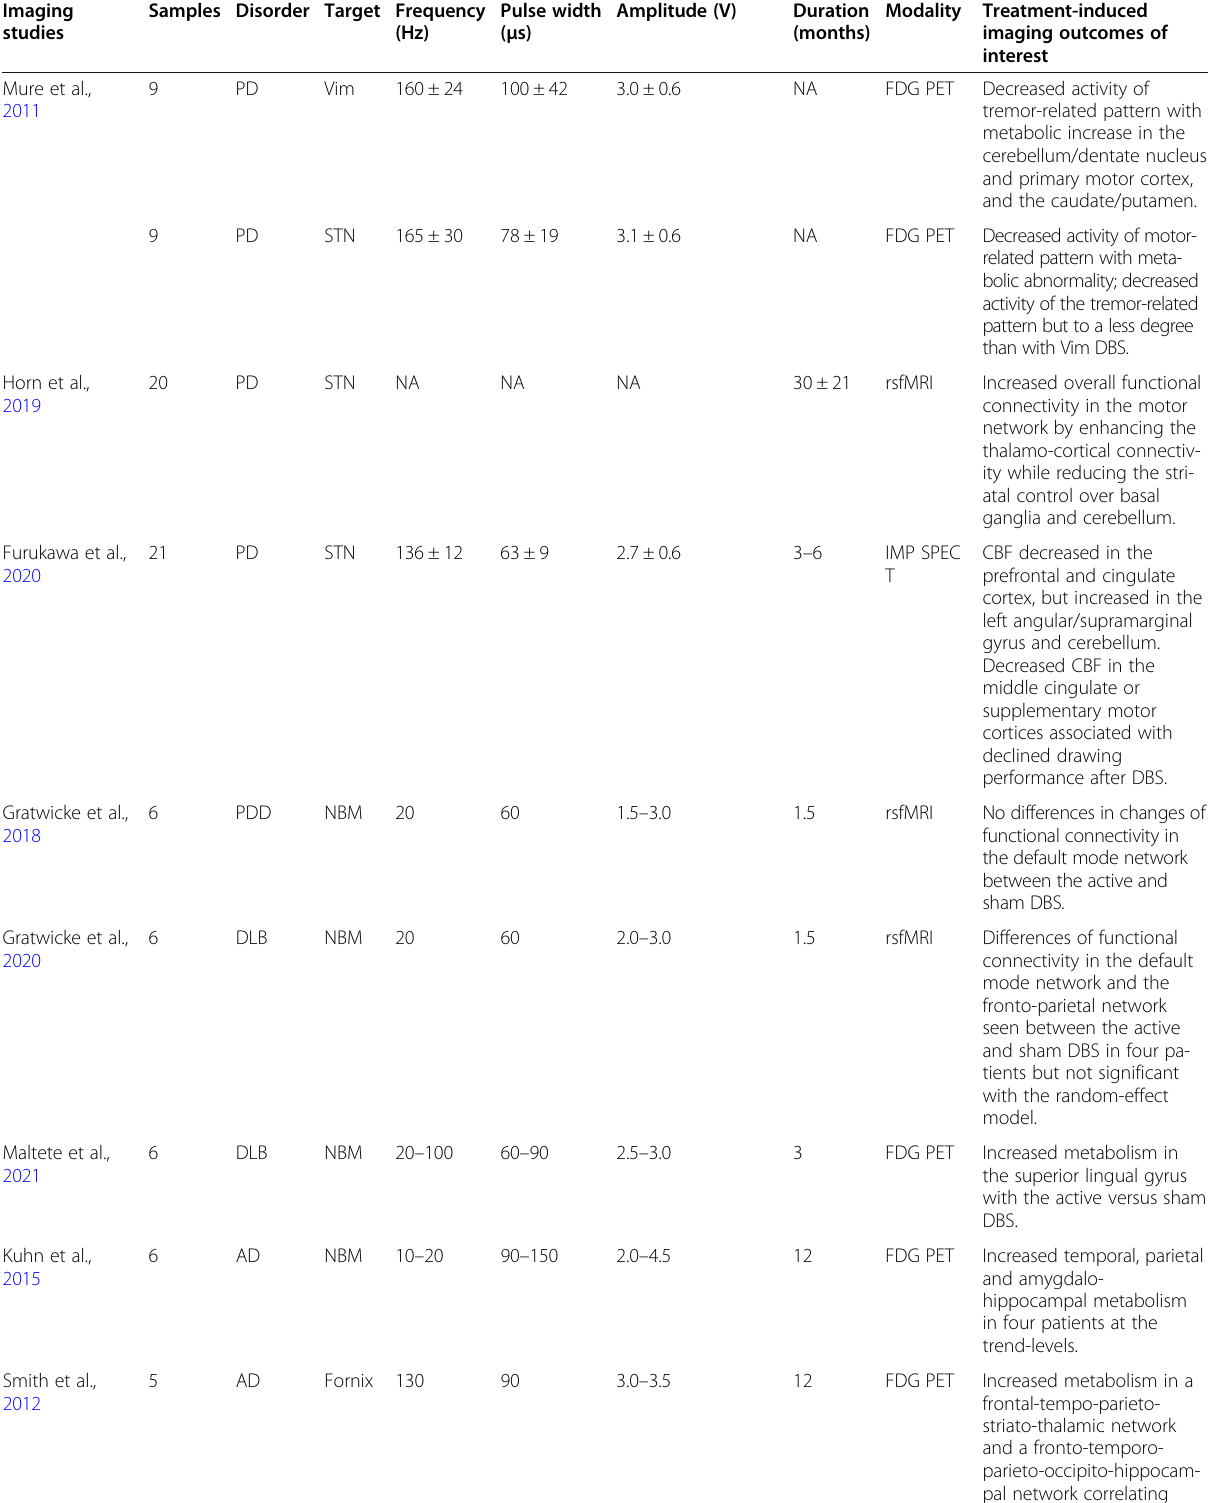
Table 1 Clinical characteristics and primary imaging outcomes of deep brain stimulation therapies in select neurodegenerative